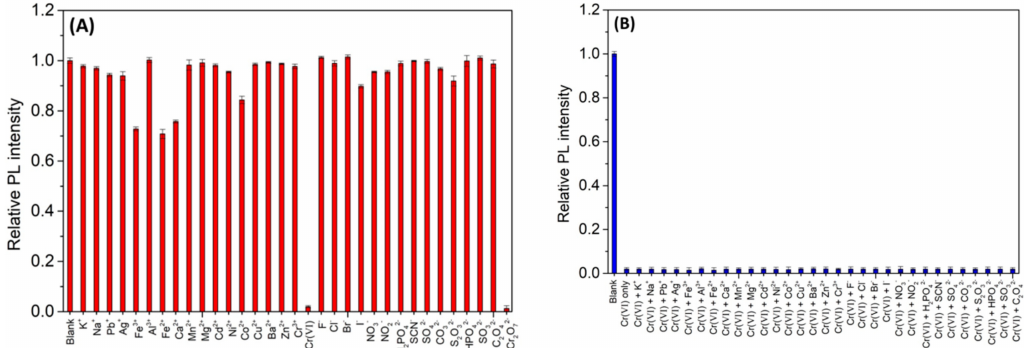
Figure 4. ( A ) The fluorescence intensity of N , Cl -CDs (1.25 mg/mL) after the addition of various metal ions and anion ions (0.5 mM); ( B ) the effects of coexisting ions (5 mM) on the fluorescence intensity of N , Cl -CDs (1.25 mg/mL)/Cr(VI) (0.5